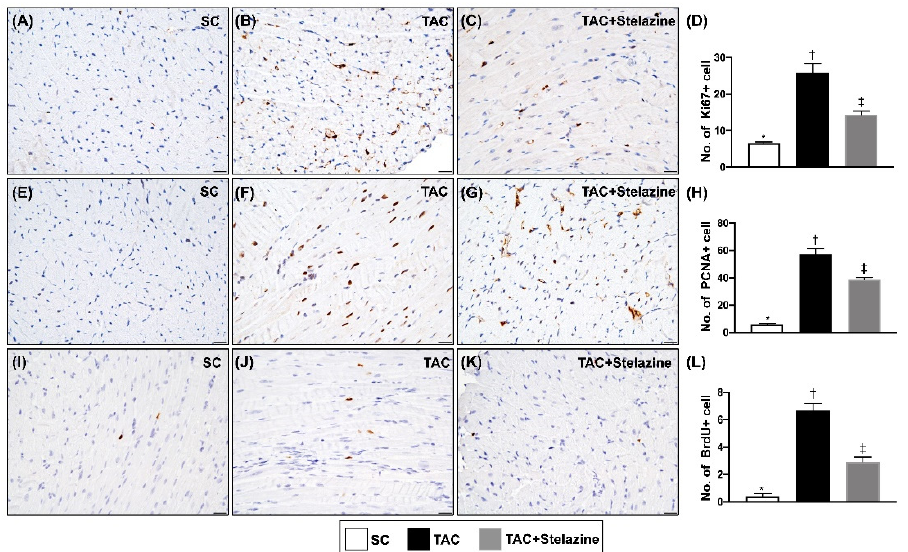
Figure 7. The proliferation biomarkers in LV myocardium by day 28 after TAC procedure. ( A – C ) Illustrating the immunohistochemical (IHC) stating (400×) for identification of Ki67+ cells (gray color). ( D ) Analytical result of number of Ki67+ cells per high-power field, * vs. other groups with di ff erent symbols (†, ‡), p < 0.0001. All scale bars in right lower corner represent 20 μ m. ( E – G ) Illustrating the IHC stating (200×) for identification of PCNA+ cells (gray color). All scale bars in right lower corner represent 50 μ m. ( H ) Analytical result of number of PCNA+ cells per high-power field, * vs. other groups with di ff erent symbols (†, ‡), p < 0.0001. ( I – K ) Illustrating the IHC staining (400×) for identification of BrdU+ cells (gray color). All scale bars in right lower corner represent 20 μ m. ( L ) Analytical result of number of BrdU+ cells per high-power field, * vs. other groups with different symbols (†, ‡), p < 0.0001. All statistical analyses were performed by one-way ANOVA, followed by Bonferroni multiple comparison post-hoc test (n = 6 for each group). Symbols (*, †, ‡) indicate significance (at 0.05 level). SC = sham-operated control TAC = transverse aortic constriction; LV = left ventricular; PCNA = proliferating cell nuclear antigen; BrdU = 5-bromo-2 ′ -deoxyuridine.